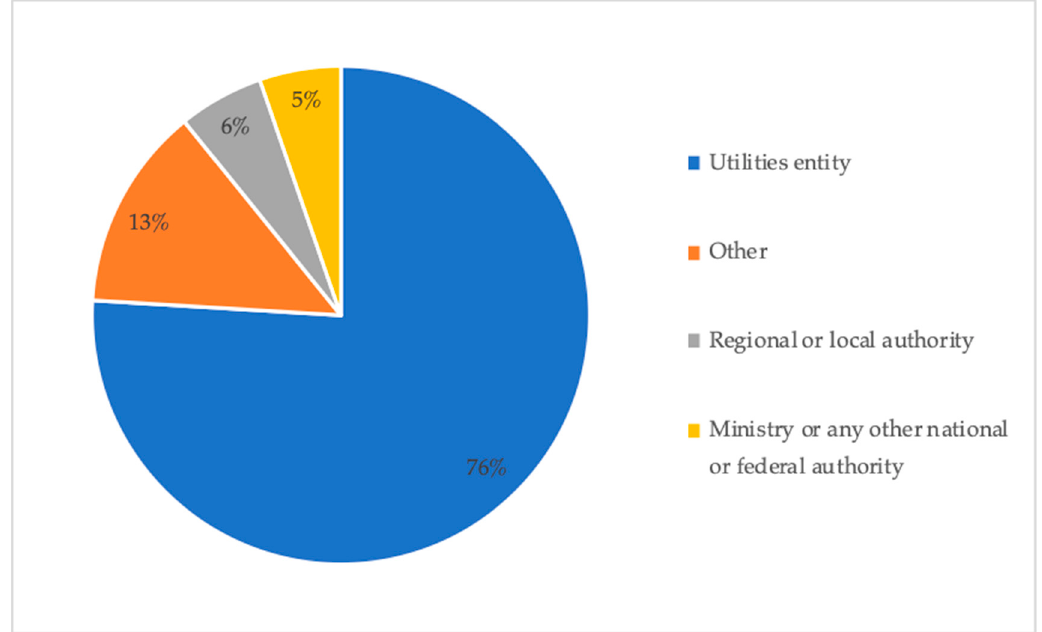
Figure 4. Notices concerning public procurement procedures for the supply of energy meters